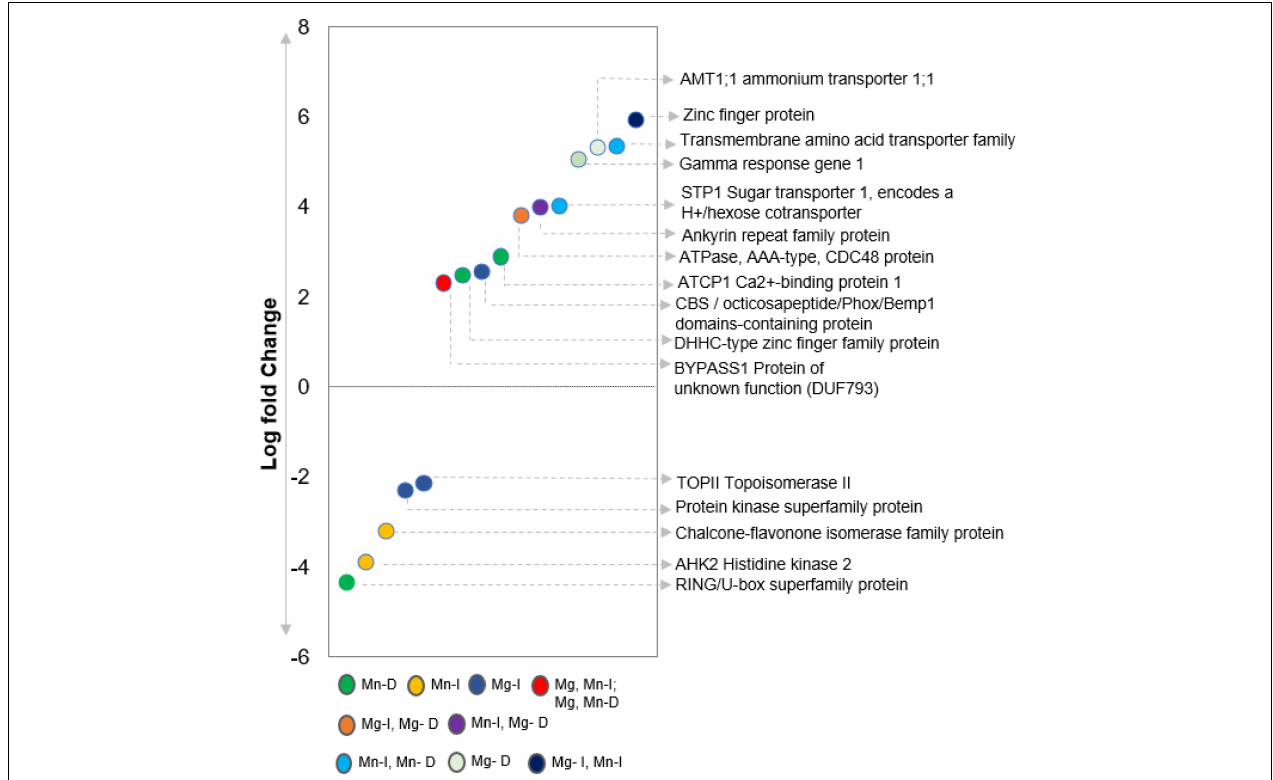
FIGURE 2 | Differential expression of ILK1 targets in Arabidopsis leaves 3 h after 1 µ M flg22 treatment relative to the 0 h time point (from Dimlioglu et al., 2022). All of the targets were identified by KiC in the presence of ILK1-V5 (I) of ILK1 D319 N -V5 (D) purified proteins with MnCl 2 (Mn) or MgCl 2 (Mg) as